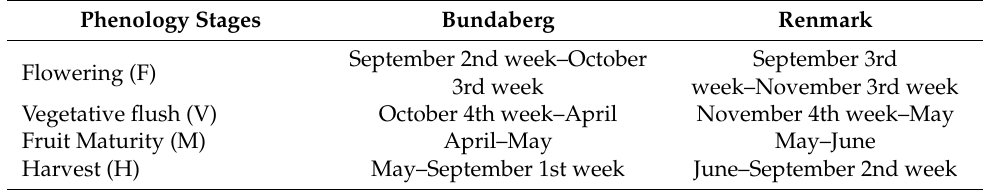
Figure 3. Avocadophenologicalstagesin( a )Bundabergand( b )Renmark(dataacquiredfromthegrowers). Figure 3. Avocado phenological stages in ( a ) Bundaberg and ( b ) Renmark (data acquired from the growers). Table 1. The four avocado phenological stages in Bundaberg and Renmark. Table 1. The four avocado phenological stages in Bundaberg and Renmark. Phenology